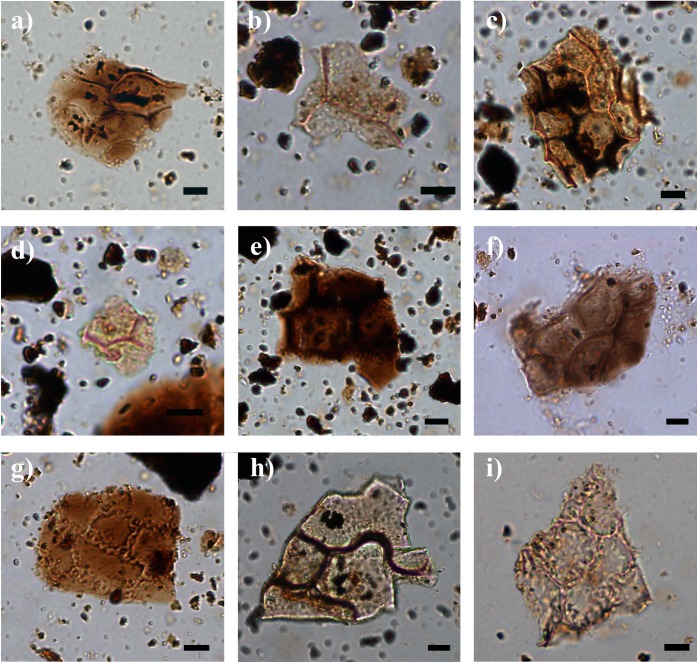
Dicot leaf phytoliths.Microphotographs of articulated phytoliths from dicotyledonous leaves showing different outlines of the cell walls from different StratAggs of PP5-6N. a) indeterminate outlines from ALBS (357374); b) indeterminate outlines from LBSR (357366); c) polyhedral outlines from LBSR (357368); d) indeterminate outlines from LBSR (357368); e) showing polyhedral outlines from LBSR (356474); f) polyhedral outlines from LBSR (162782); g) sinuate outlines from LBSR (357365); h) sinuate outlines from LBSR (162778); i) sinuate outlines from LBSR (162549). Pictures taken at 400x. Scale bar represents 10 mm.